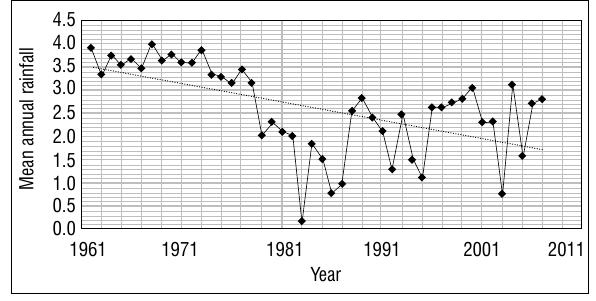
Figure 3: Mean annual rainfall (mm) changes in the Makonde Rural District from 1962 to 2008.